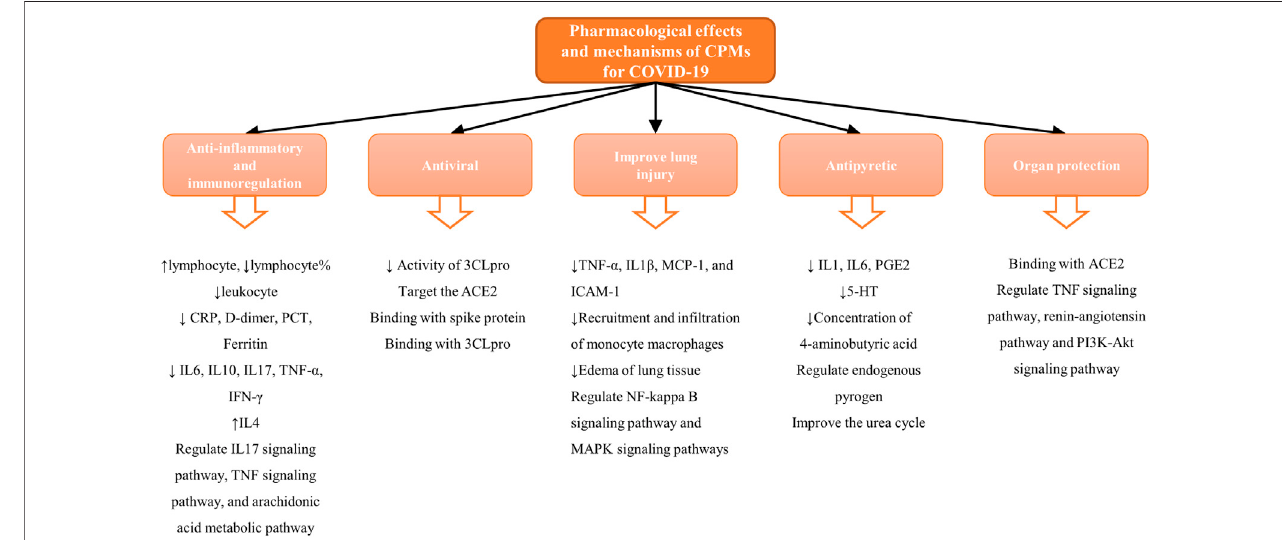
FIGURE 3 | The pharmacological effects and mechanisms of CPMs for